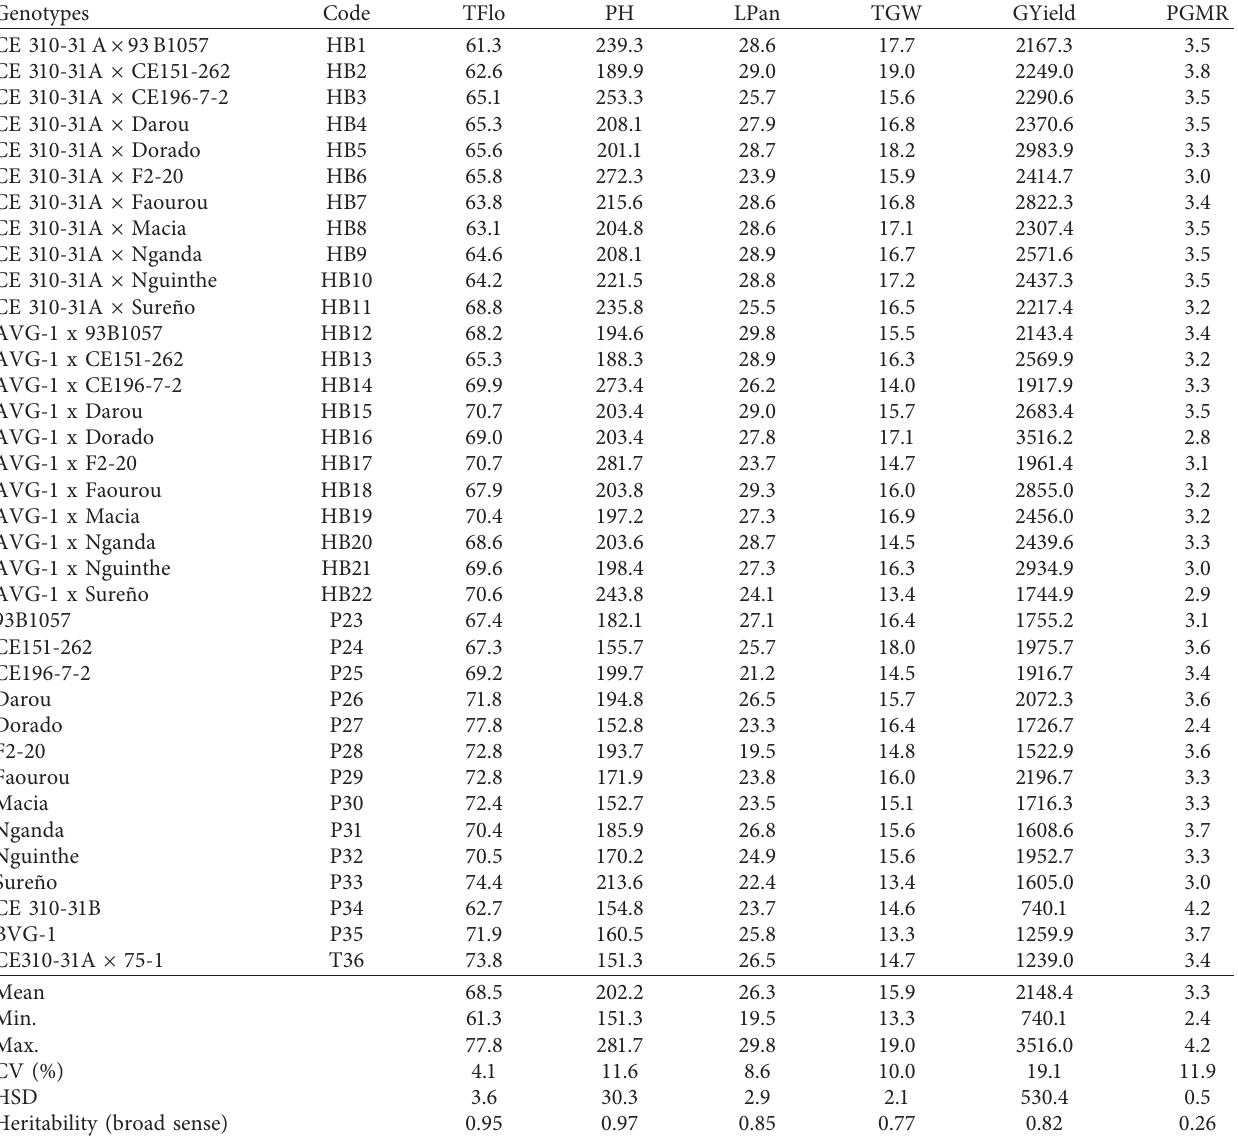
Table 3: Mean per se performance of parental lines and their hybrids across the test